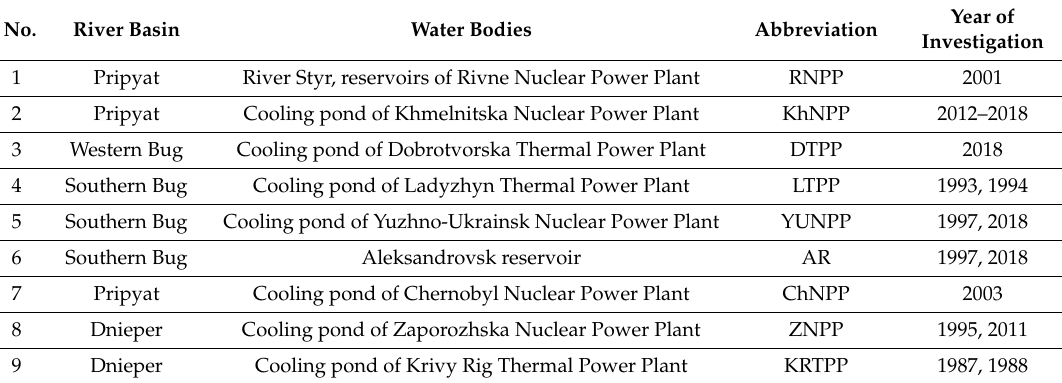
Figure 1. Investigated water bodies on the territory of Ukraine. The number of the waterbodies is the same as in Table 1. Table 1. Major characteristic of the investigated water bodies in Ukraine with studied periods.